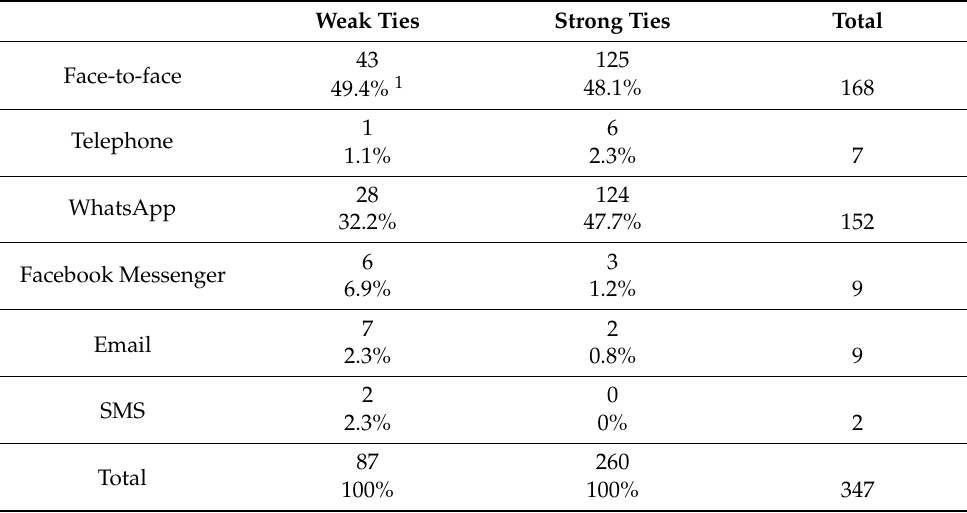
Table 2. Frequencies and percentages of communication tools for weak and strong